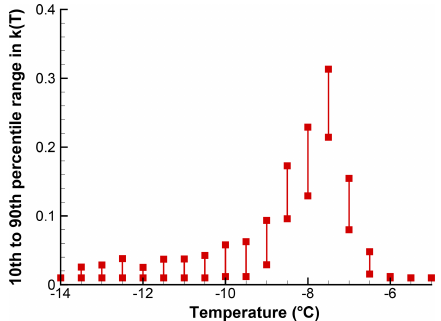
Figure 9. Cumulative spectra for 100 simulations for which differ- ential spectra are shown in Fig. 7. Figure 10. The 10th to 90th percentile range of k(T ) in 100 simula- tions for a segment of the spectrum shown in Fig. . Points just above the abscissa stand for zero values. In contrast with other figures, a linear ordinate scale is used because of the small range of values covered. A value of X = 1 is used; actual drop volume of particle concentration is not accounted